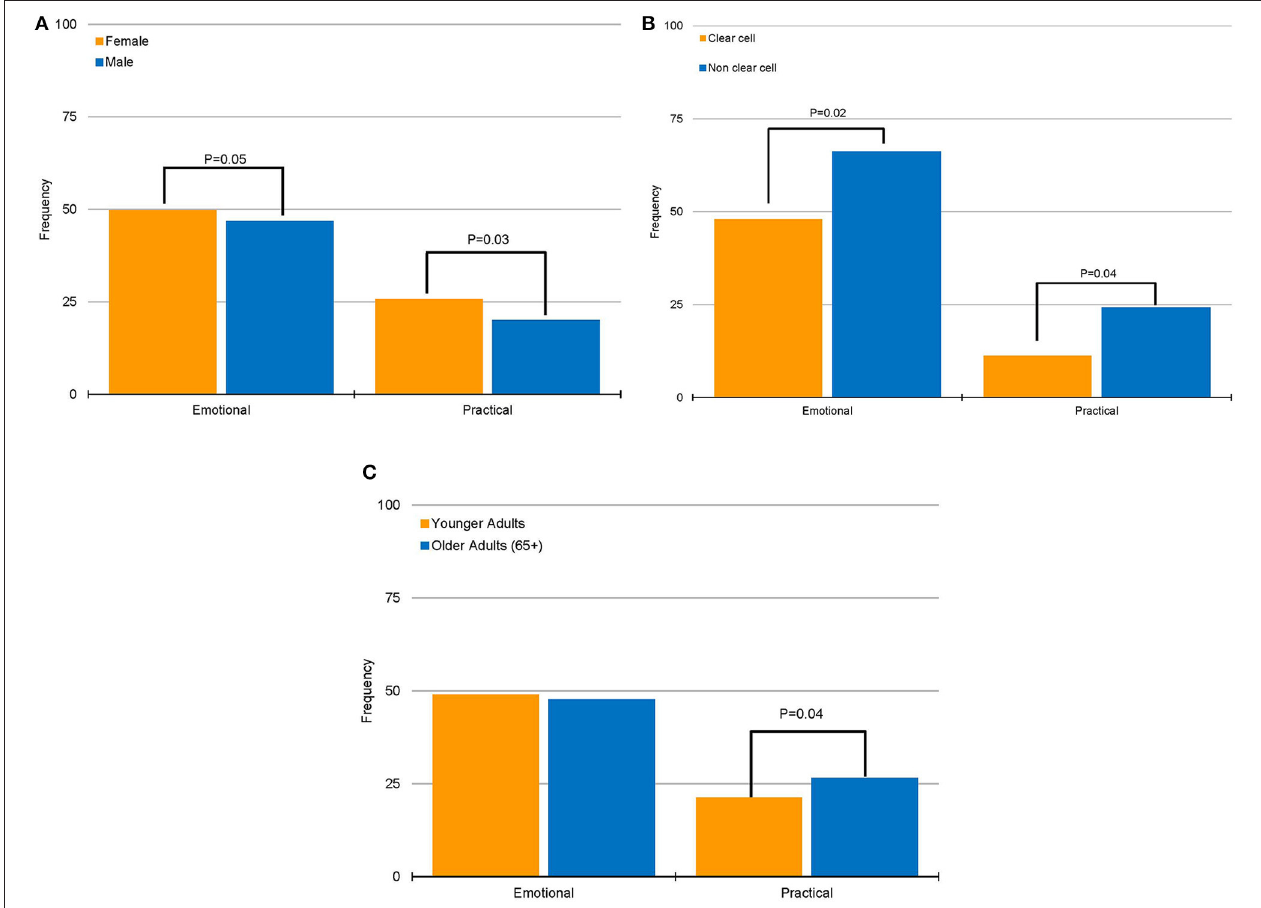
FIGURE 1 | Associations of emotional and practical sources of frustrations with patient characteristics. (A) Association between gender and sources of frustration. (B) Association between histology group and sources of frustration. (C) Association between age group and sources of frustration.